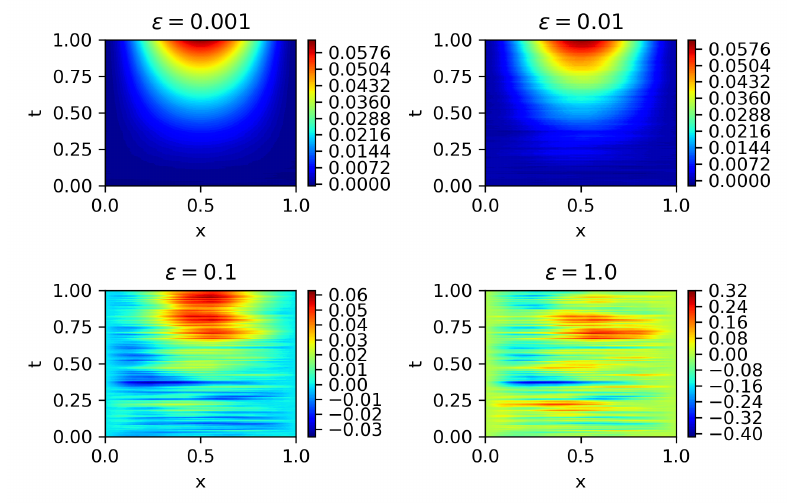
Figure A3. Solution to forward problem: Effect of noise magnitude (cid:101) on numerical solution for fixed realization of white noise ω 0